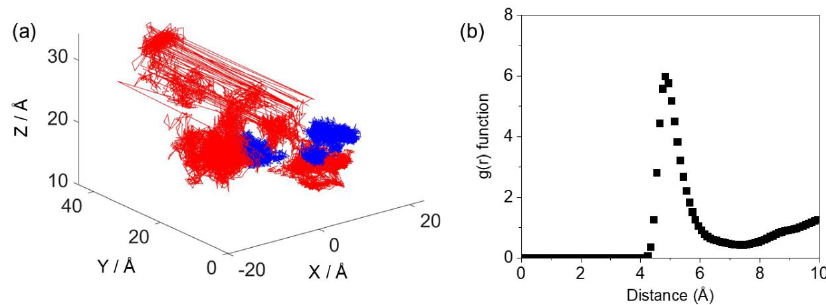
Figure 10. ( a ) MD simulation trajectory of BMI + ion (red color) and PF 6 − ion (blue color). ( b ) Radical distribution function between BMI + ion and PF 6 − ion. distribution function between BMI + ion and PF 6 −